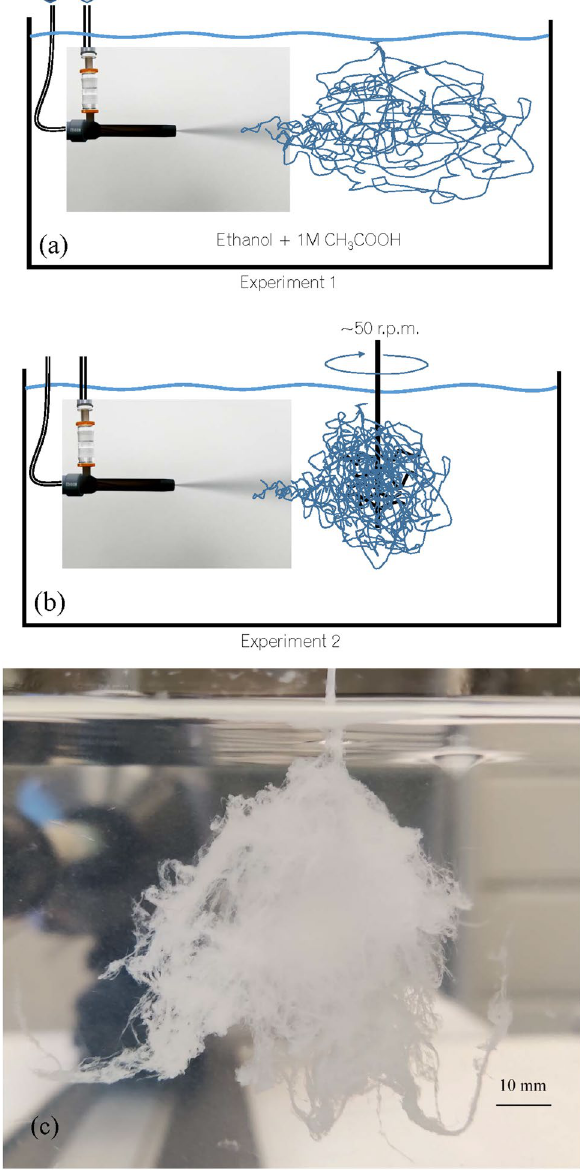
Figure 3. ( a ) Experiment 1, fiber free-blowing process. ( b ) Experiment 2: fiber blowing with collection. ( c ) The cotton-like fibrous material collected from a single 25-s ejection of 1.5 g of the fibroin solution, from experiment 1 (as-blown